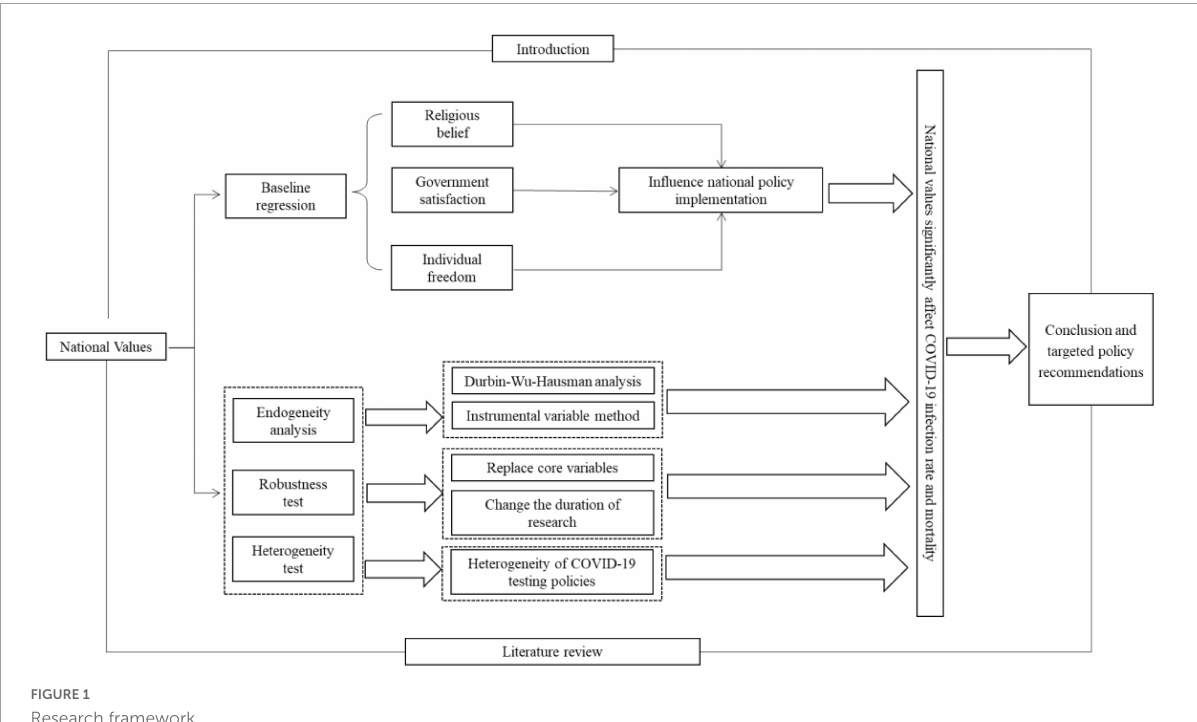
FIGURE1 Research